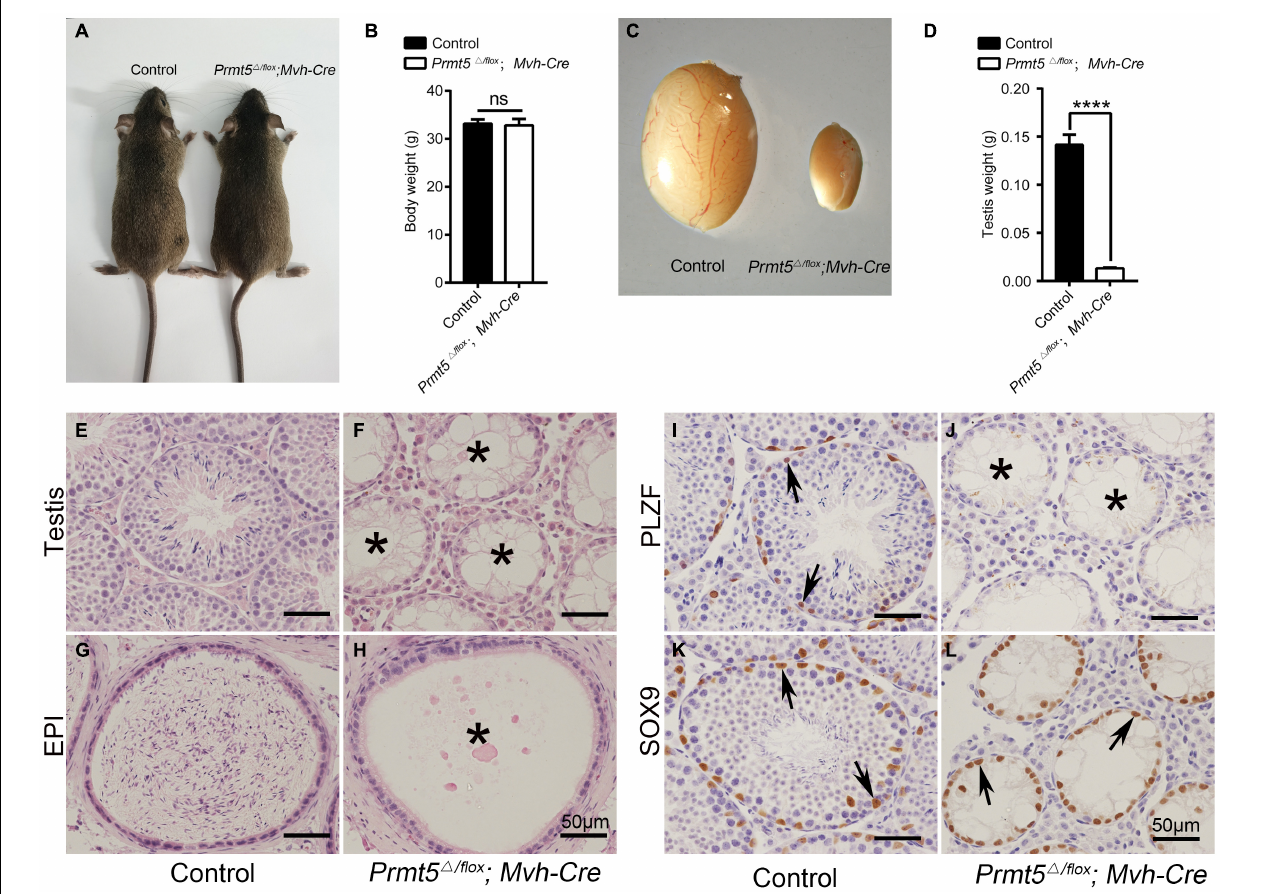
FIGURE 1 | Deletion of Prmt5 causes germ cell loss and male infertility. No obvious developmental abnormalities were observed in adult Prmt5 (cid:49)/ flox ;Mvh-Cre mice (A) , and the body weights were comparable to those of control littermates (B) . The size of testes from Prmt5 (cid:49)/ flox ;Mvh-Cre mice was significantly smaller than that of control littermates (C,D) . Germ cells at different developmental stages were observed in control testes (E) , whereas most seminiferous tubules were empty in adult Prmt5 (cid:49)/ flox ;Mvh-Cre testes (F , asterisks). The cauda epididymis of control males was filled with mature sperm (G) , but no mature sperm were observed in the epididymis of Prmt5 -deficient males (H) . PLZF-positive spermatogonia were located at the peripheral region of the seminiferous tubules in control mice [ (I) , black arrows], whereas no PLZF-positive spermatogonia were observed in Prmt5 (cid:49)/ flox ;Mvh-Cre mice (J) . SOX9-positive Sertoli cells were observed in the seminiferous tubules of both control [ (K) , black arrows] and Prmt5 (cid:49)/ flox ;Mvh-Cre mice [ (L) , black arrows]. Error bars represent the SEM of triplicate results. **** P < 0.00001 indicates a significant difference ( t